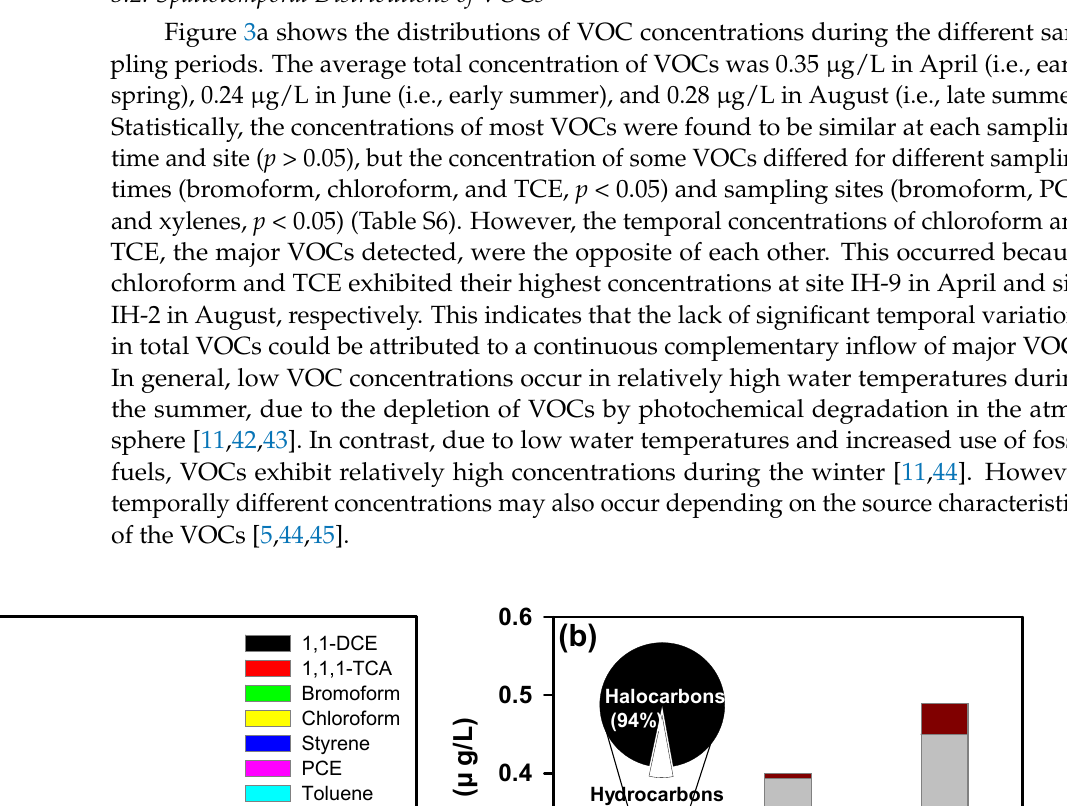
Figure 4. ( a ) Loading plot and ( b ) scores plot of the PCA. Xylenes include m ‐ , o ‐ , and p ‐ isomers of xylene; N: Namhan River; B: Bukhan River; IH: Imjin ‐ Hantan River; H: Han River mainstream; A: Anseong Stream. Halocarbons (i.e., halogenated VOCs) accounted for 94% of the total VOCs due to the compositions of the major VOC types. The composition ratio of the halocarbon VOCs was similar in almost all of the sub ‐ watersheds. In the Anseong Stream watershed, the com ‐ position ratio of hydrocarbon VOCs was relatively high (15%). In addition, PCE, which is a solvent widely used in dry cleaning, was detected only in the Imjin ‐ Hantan River, Han River mainstream, and Anseong Stream watersheds. There are industrial complexes